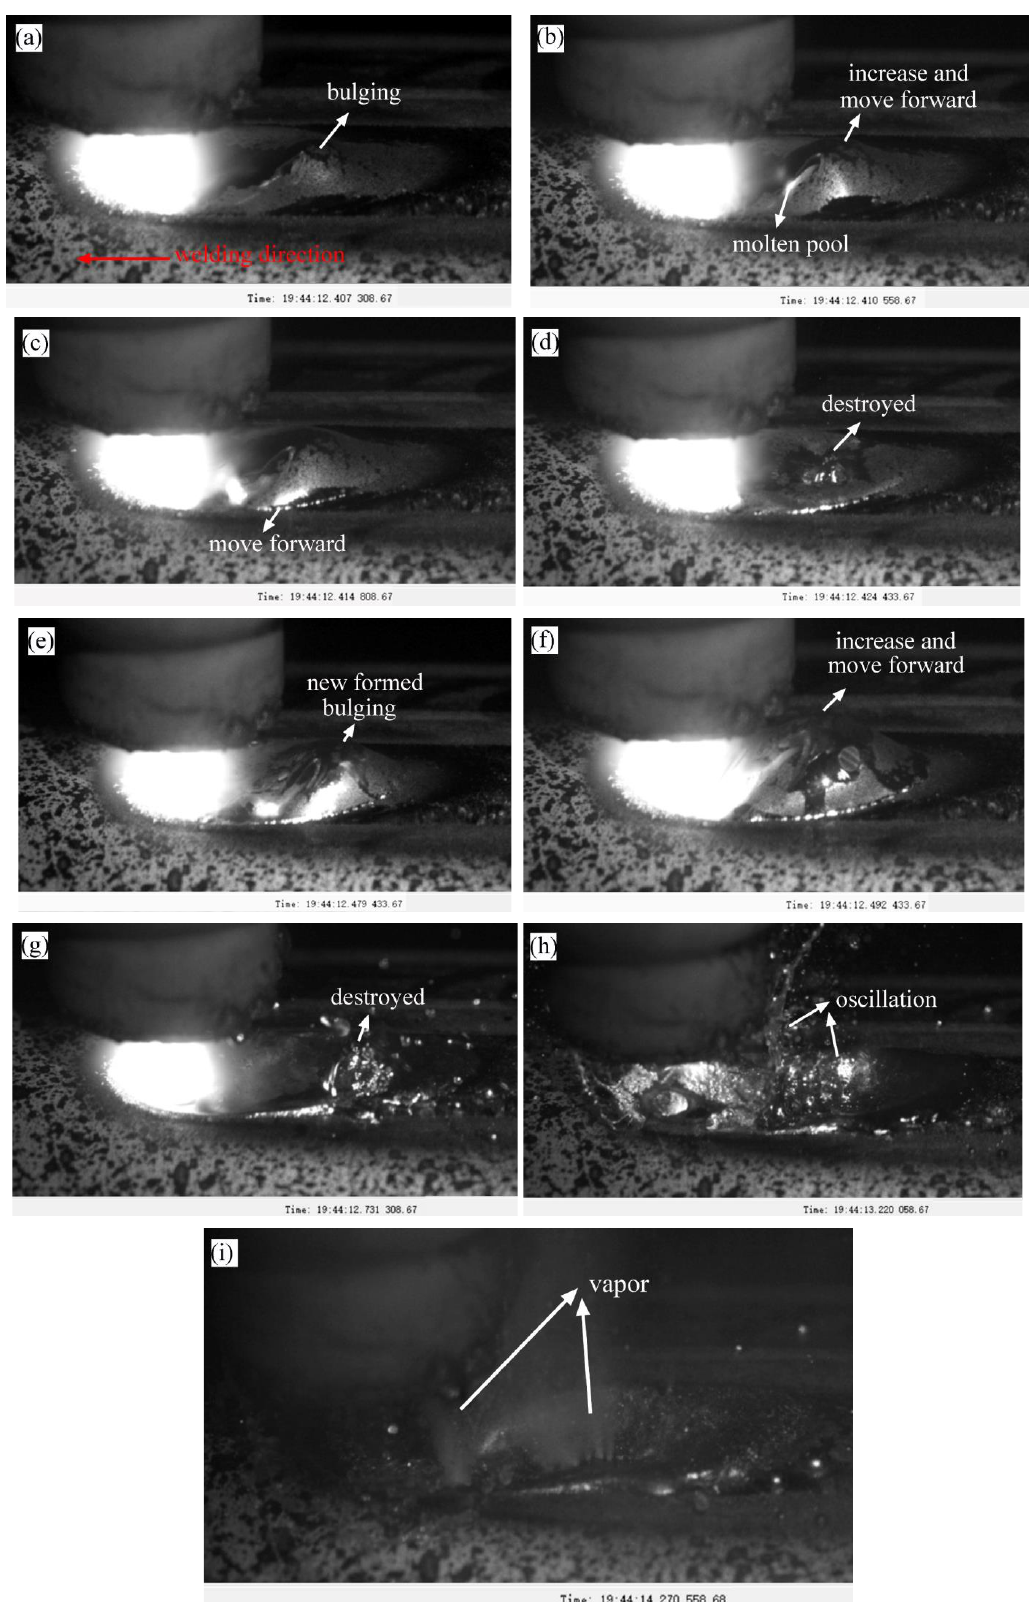
Figure 9. Dynamic evolution behavior during the burn-through process of the 17-ZD-11: ( a ) 0.407 s; ( b ) 0.411 s; ( c ) 0.415; ( d ) 0.424 s; ( e ) 0.479 s; ( f ) 0.492 s; ( g ) 0.731 s; ( h ) 1.220 s; ( i ) 1.271 s.